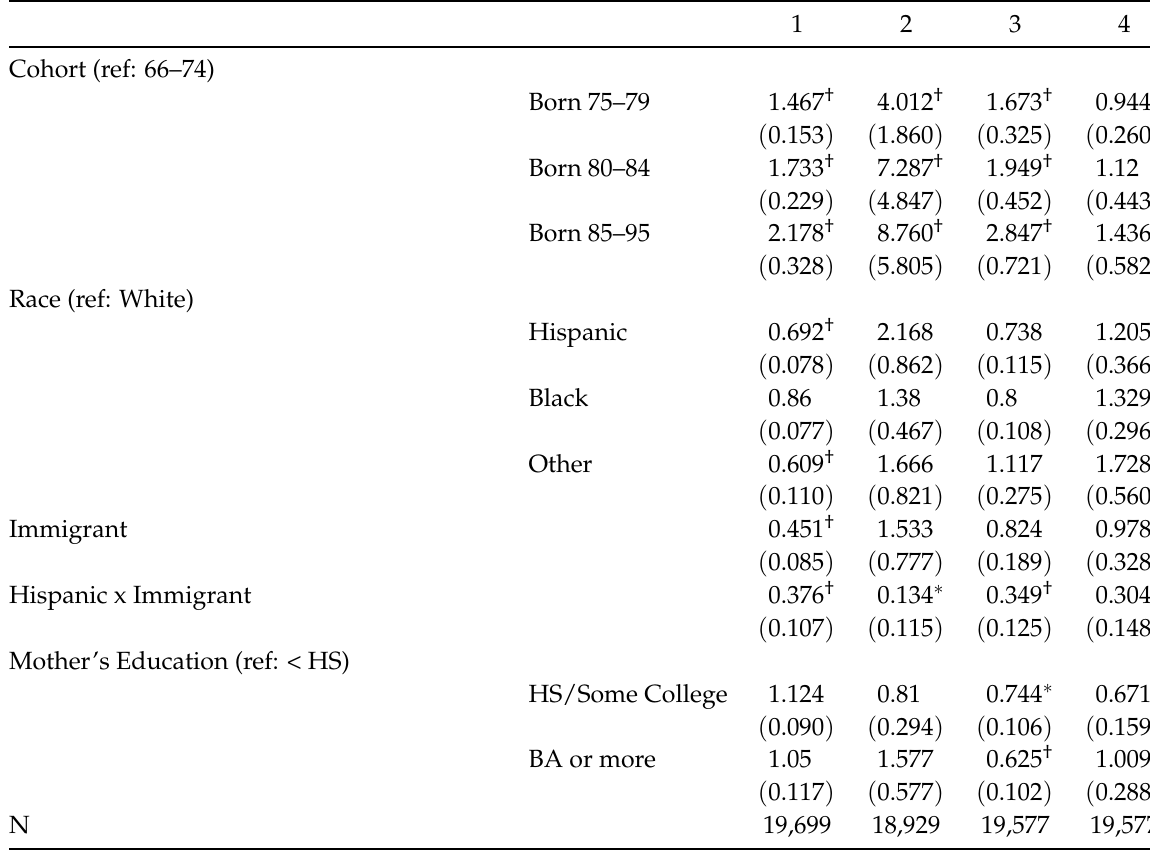
Table 2: Odds ratios from four logistic regressions predicting whether women (1) have had male and female sexual partners (ever), (2) have had only female sexual partners (ever), (3) identify as bisexual, and (4) identify as